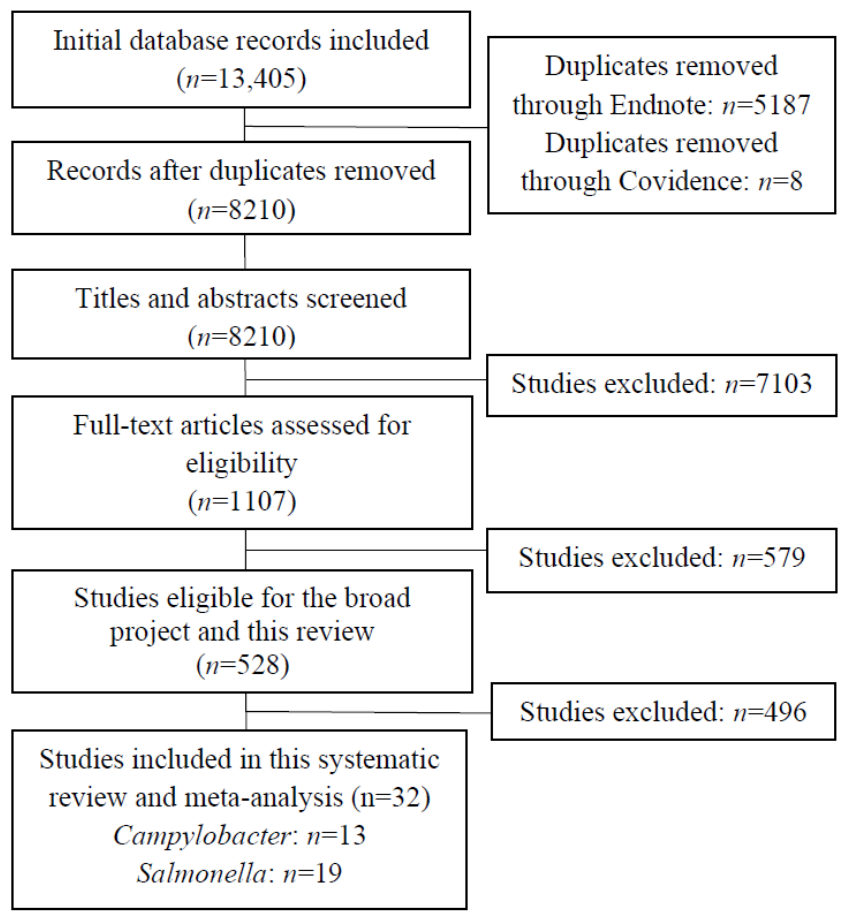
Figure 1. PRISMA flow diagram illustrating the number of studies included at each screening stage.